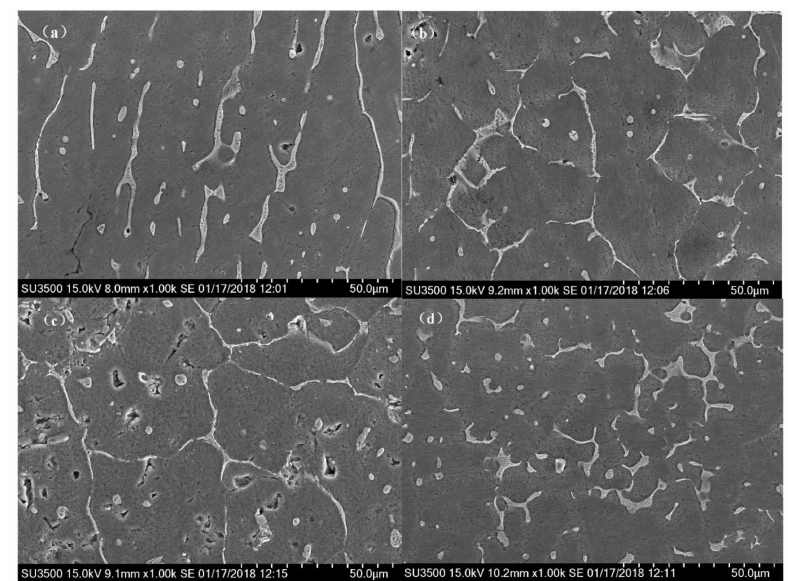
Figure 9. Scanning electron micrographs for the 2219 aluminum alloys using different arc modes: ( a ) CMT; ( b ) CMT-ADV; ( c ) CMT-P, and ( d )